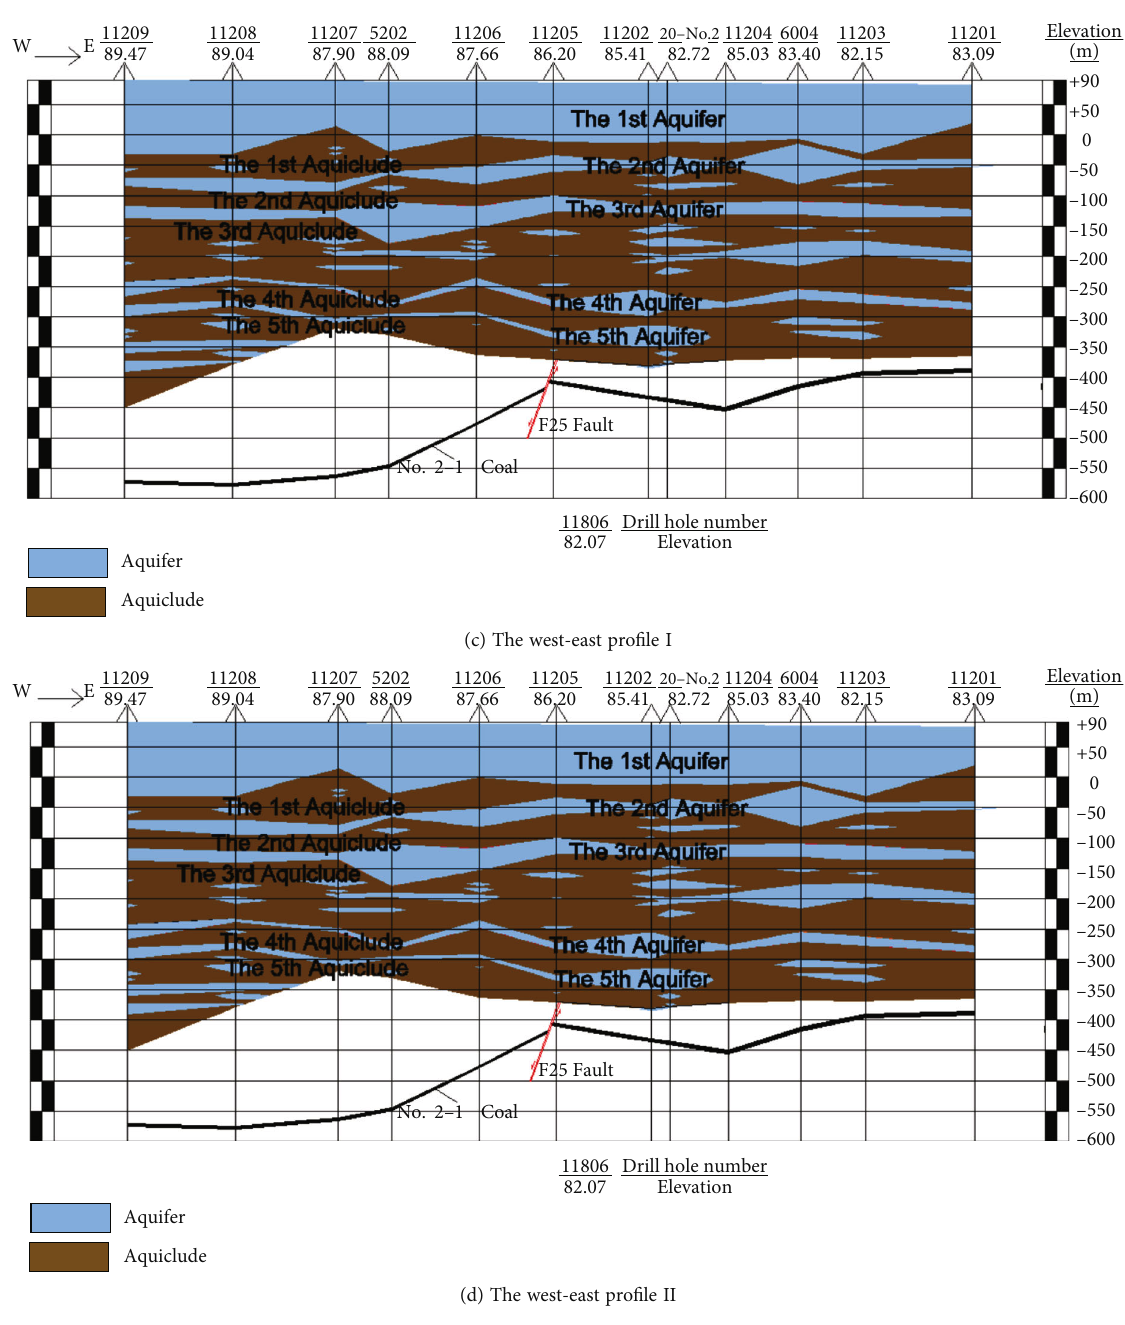
Figure 5: The pro fi le of alluvium of the north fl